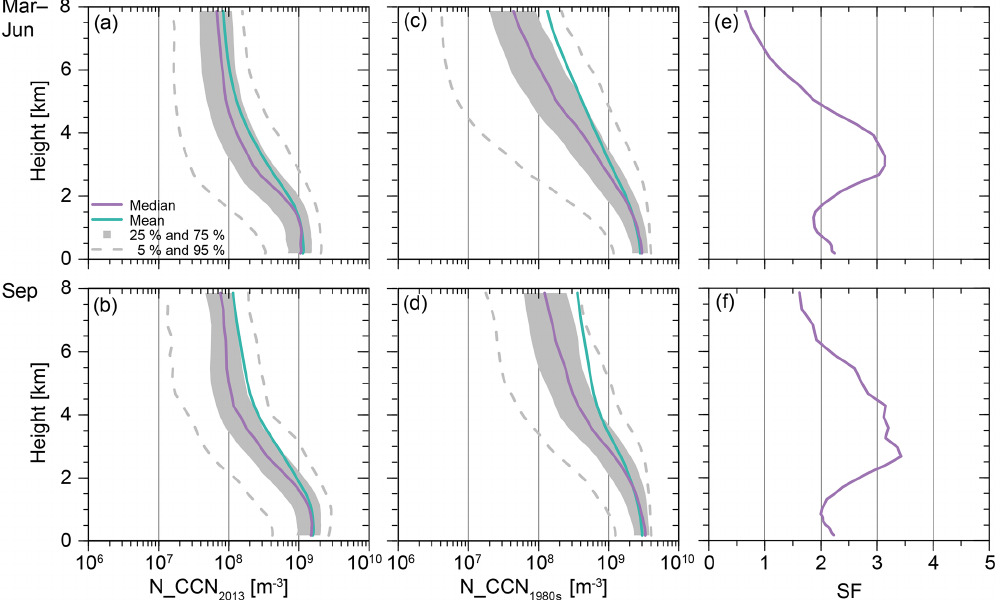
Figure 7. Spatially and temporally averaged vertical profile of the CCN number concentration as computed by COSMO-MUSCAT for the spring and fall period in 2013 (a, b) , the estimation for the respective mid-1980s peak aerosol scenario (c, d) , and the scaling factor (SF) for the two scenarios (SF = N_CCN 1980 s /N_CCN 2013 ; e and f ). For the calculation of the CCN number concentration, a vertical velocity of 1ms − 1 was